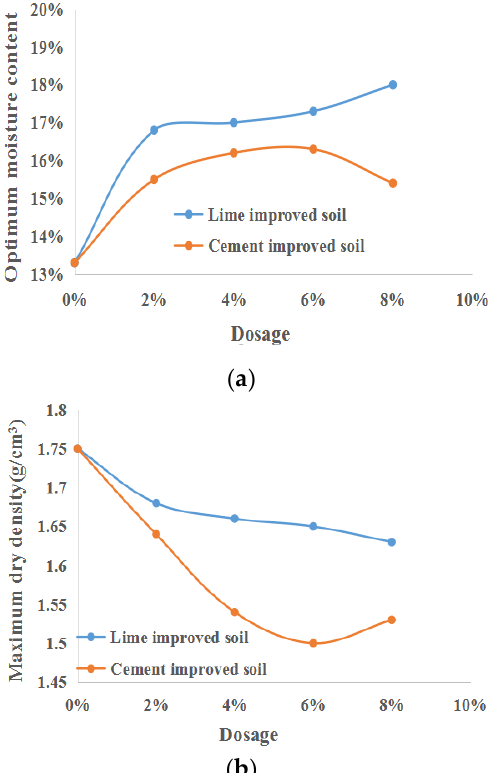
Figure 2. Variation curve of optimum water content and maximum dry density of modified soil with different dosages. ( a ) optimum water content, ( b ) maximum dry density.